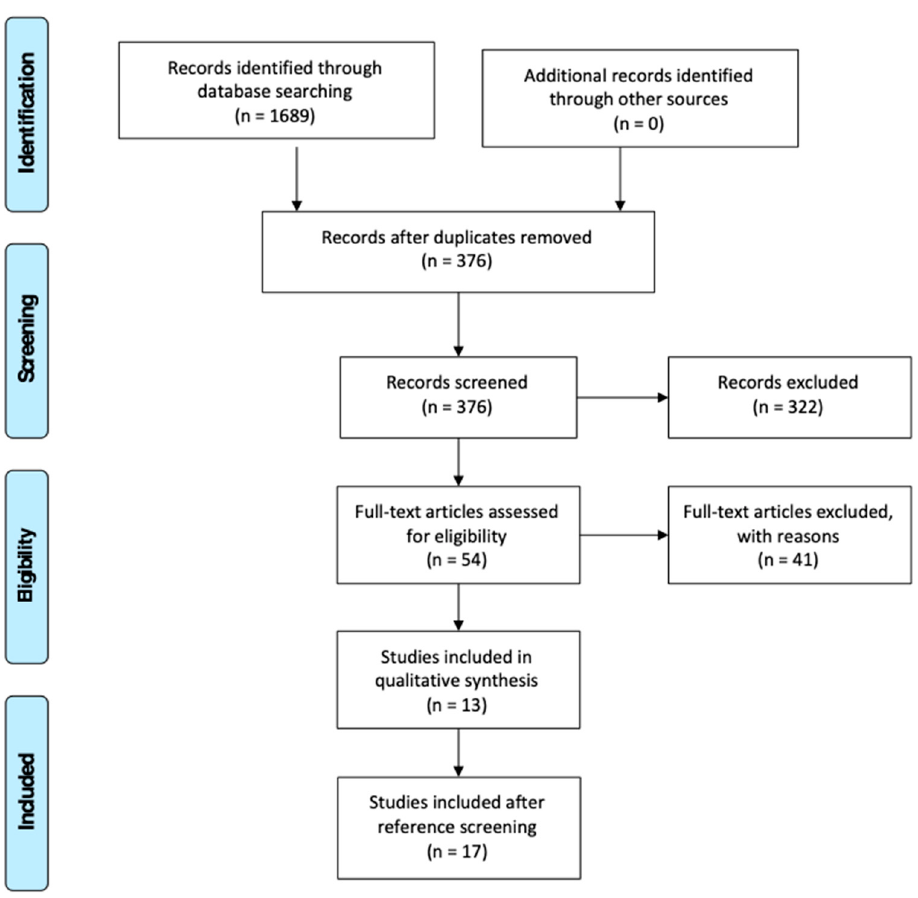
Figure 2. PRISMA flow diagram of article selection process.